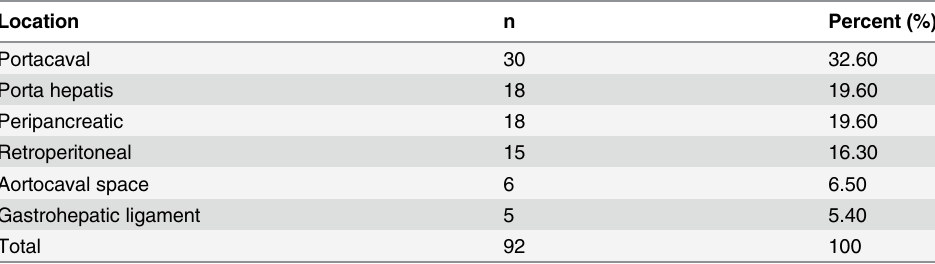
Table 4. Specific distribution of enlarged lymph